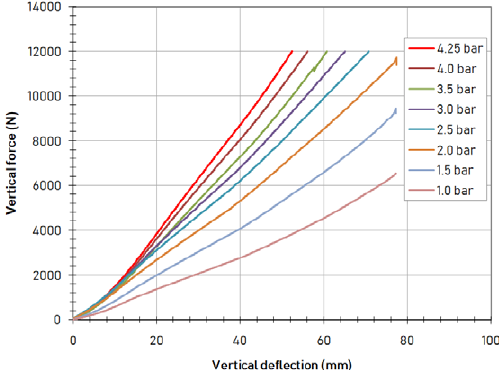
Figure 7. Summary of tyre compression curves for all pressure variants